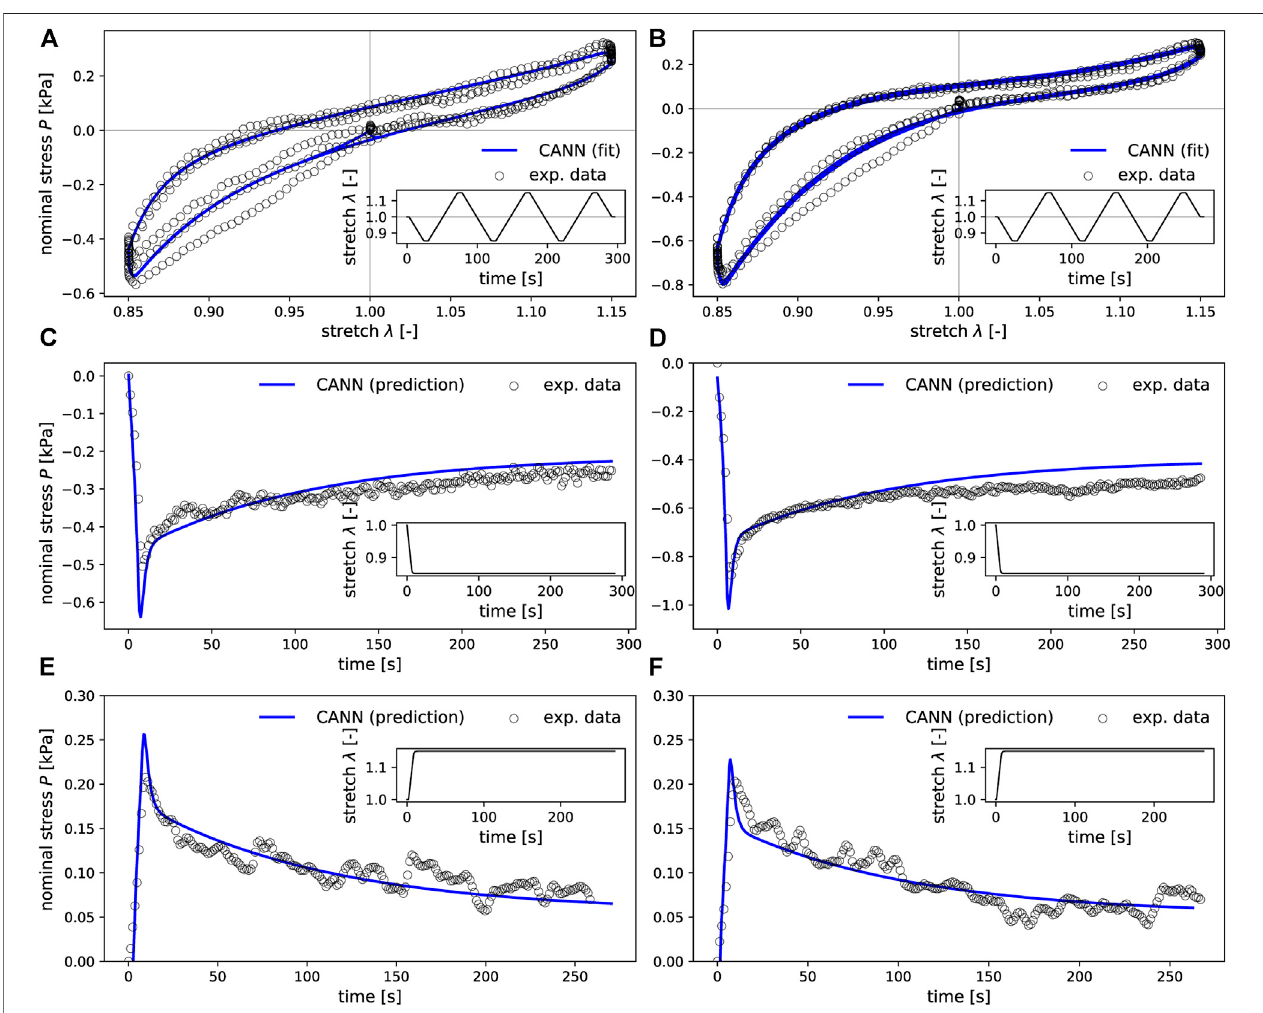
FIGURE6| CANNsextendedbytheabilitytoaccountforviscoleasticeffectsandcanlearntoresemblethestress-straincurvesprovidedastrainingdata (A,B) and to predict the stress response also for loading scenarios not included in the training data such as the relaxation experiments shown in (C – F) . The fi rst column (A,C,E) corresponds to mechanical data of one representative sample from the basal ganglia, while the second column (B,D,F) corresponds to a sample from the cerebellar white matter brain region.